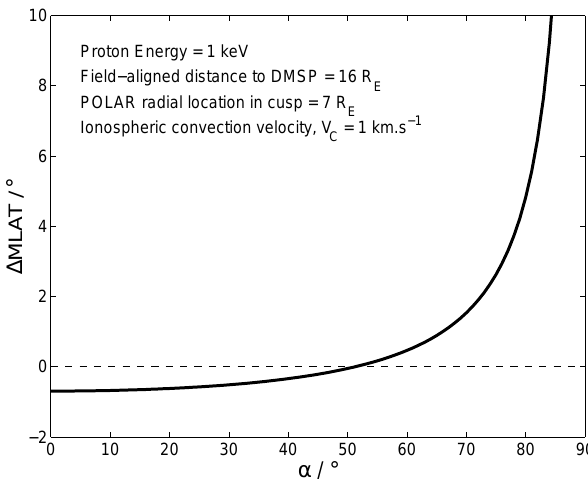
Fig. 4. The estimated difference in the MLAT of 1keV H + cusp ions observed at POLAR and DMSP ( 1 MLAT) as a function of ion pitch angle ( α ). 1 MLAT > 0 indicates that cusp ions are observed further poleward at POLAR than at DMSP, and vice versa. Here we have assumed a field-aligned distance from the subsolar reconnec- tion X-line to DMSP and POLAR of ≈ 15 R E and ≈ 9 R E , respec- tively; and an ionospheric convection velocity, V C = 1km.s − 1